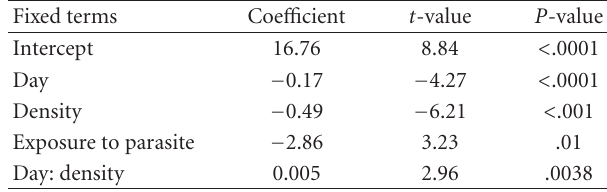
Table 2: Minimal adequate model for number of eggs laid per snail per week, determined using deletion testing as